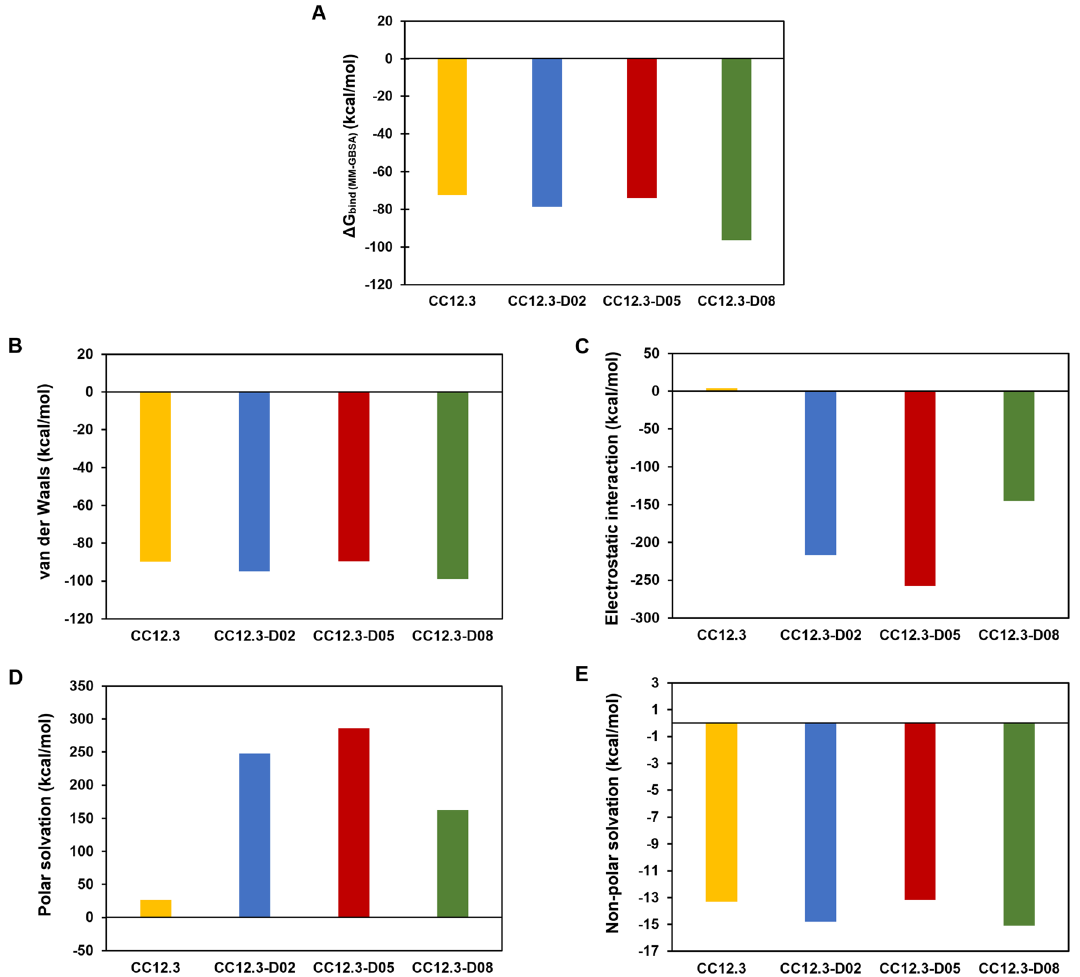
Figure 2. Binding free energy components of CC12.3/SARS-CoV-2-RBD, CC12.3-D02/SARS-CoV-2-RBD, CC12.3-D05/SARS-CoV-2-RBD, and CC12.3-D08/SARS-CoV-2-RBD. ( A ) ΔG bind (MM-GBSA) , ( B ) van der Waals energy, ( C ) electrostatic interaction, ( D ) polar solvation, and ( E ) non-polar